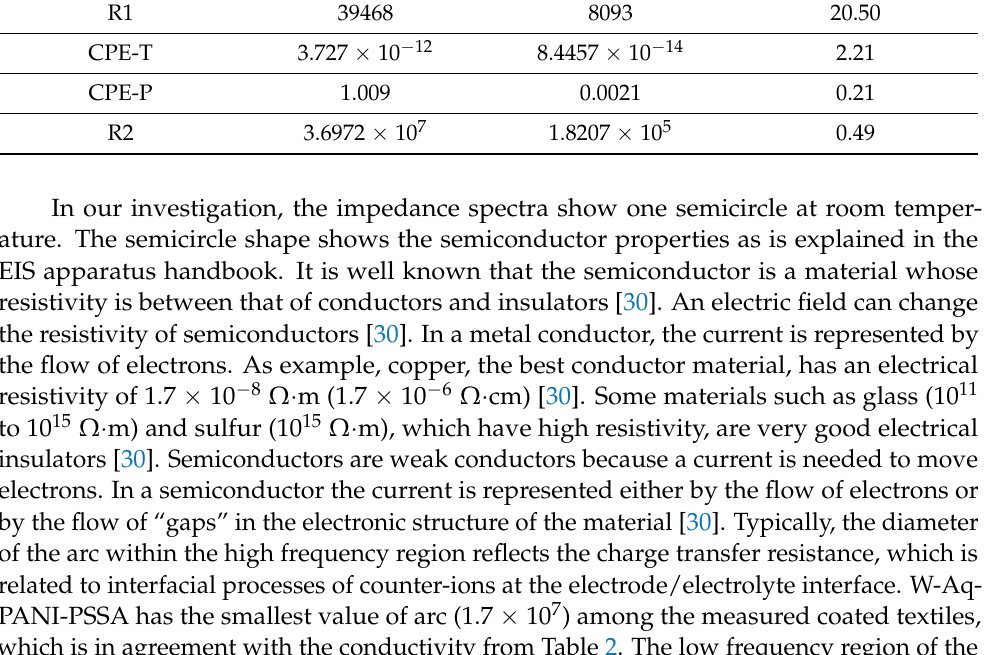
plot for materials obtained by emulsion route.